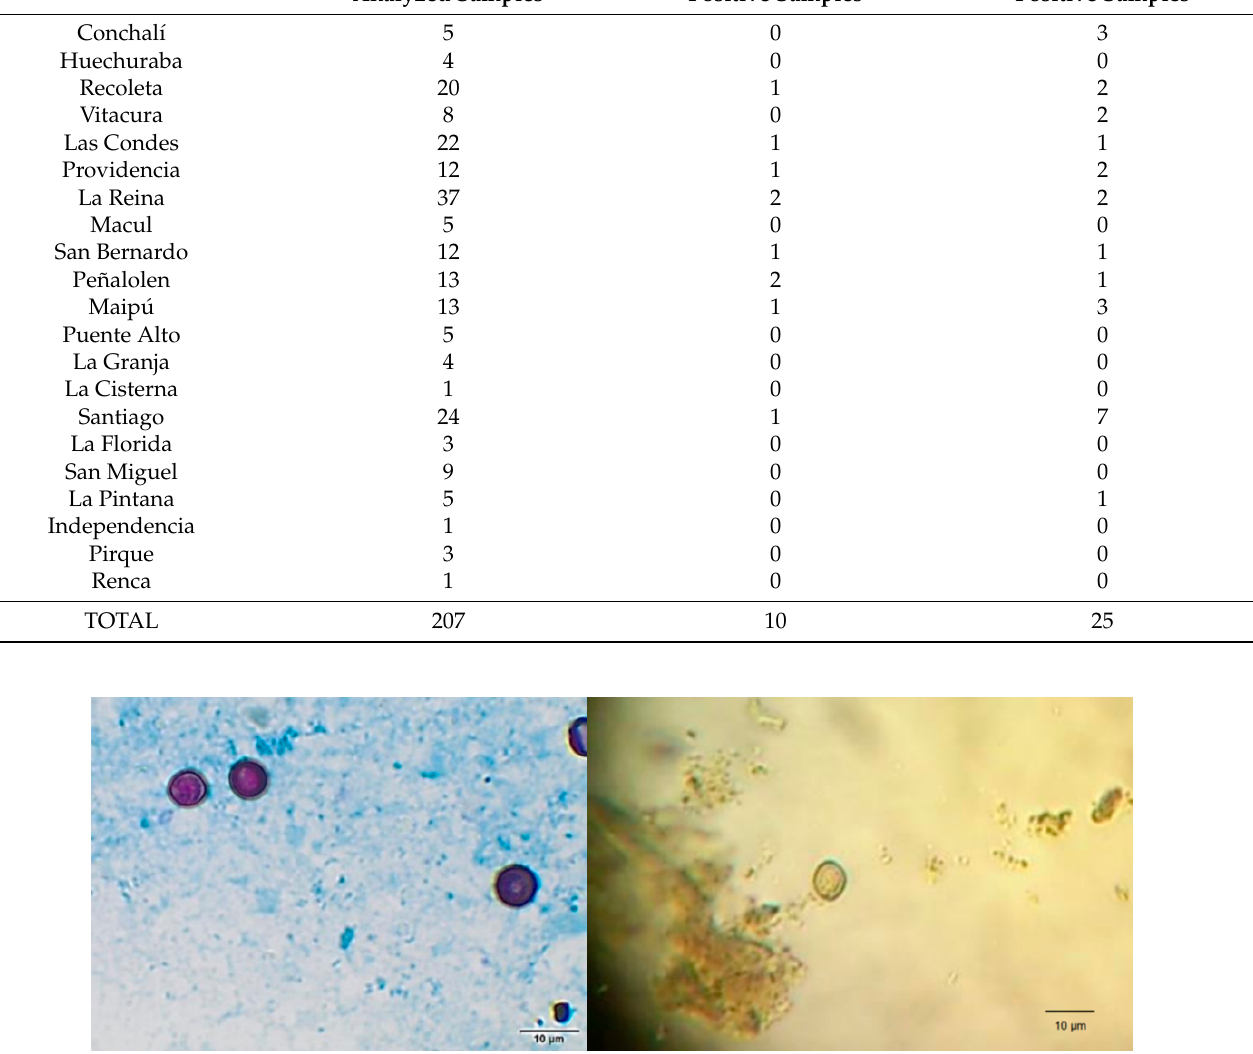
Table 1. Number of positive parakeets to Cryptosporidium spp. and to Giardia spp. per municipality. Cryptosporidium spp. Giardia spp. Total Number of Municipality Analyzed Samples Positive Samples